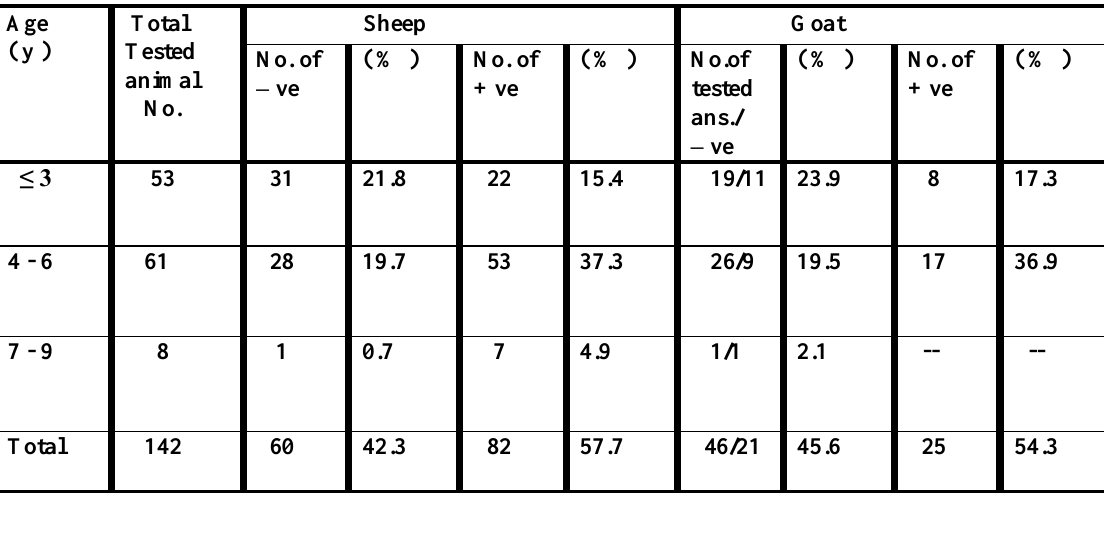
Table (3) prevalence of toxoplasmosis in different ages between sheep and goats by